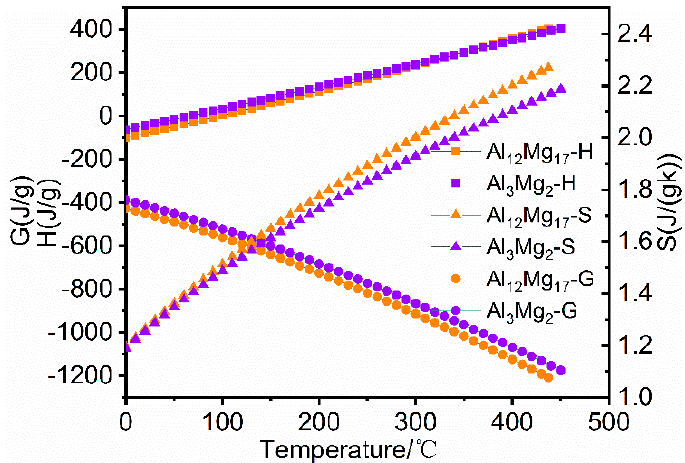
Figure 9. Thermodynamic calculation of Al 3 Mg 2 and Al 12 Mg 17 phases.